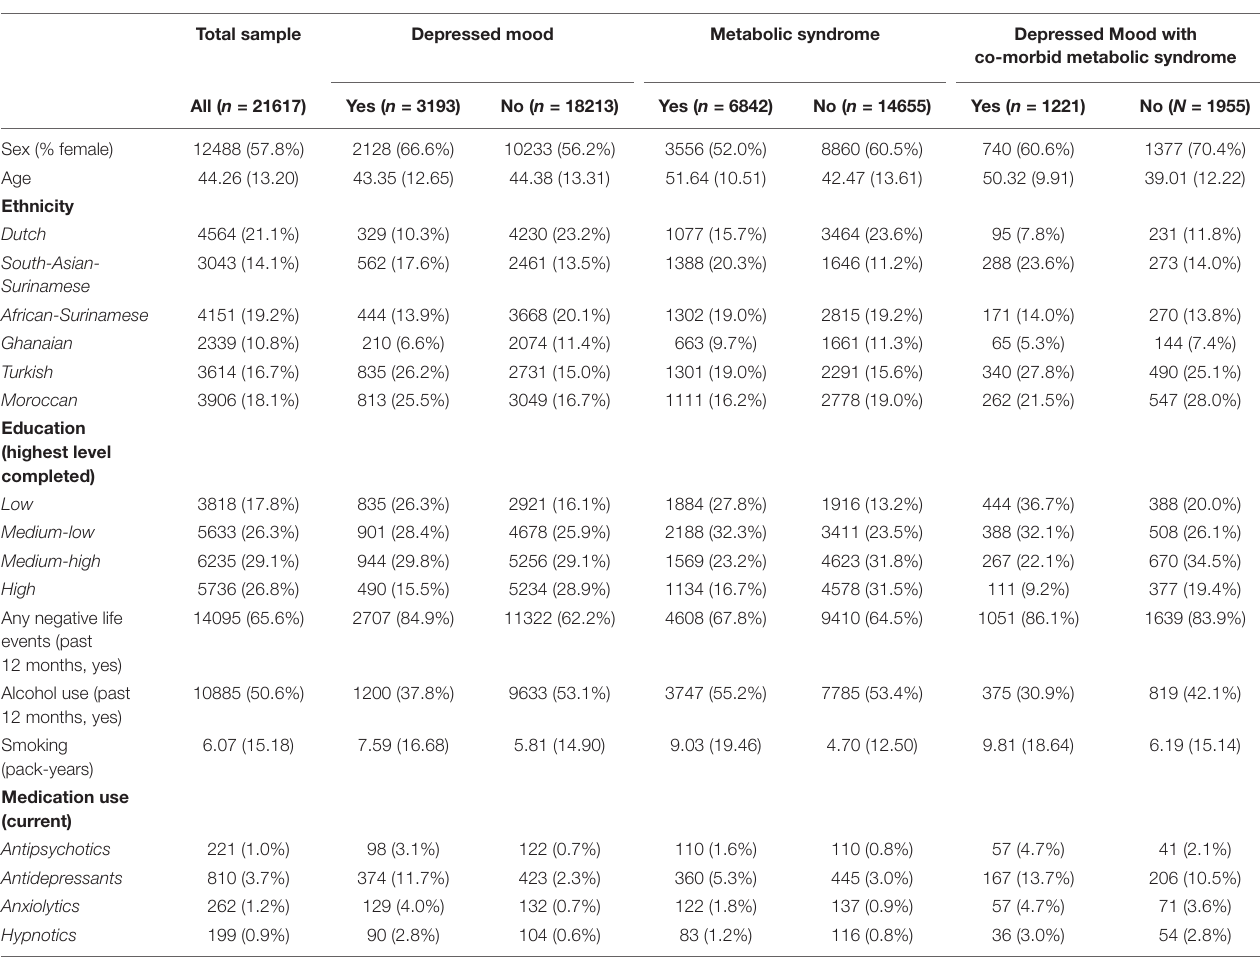
TABLE 1 | Participant